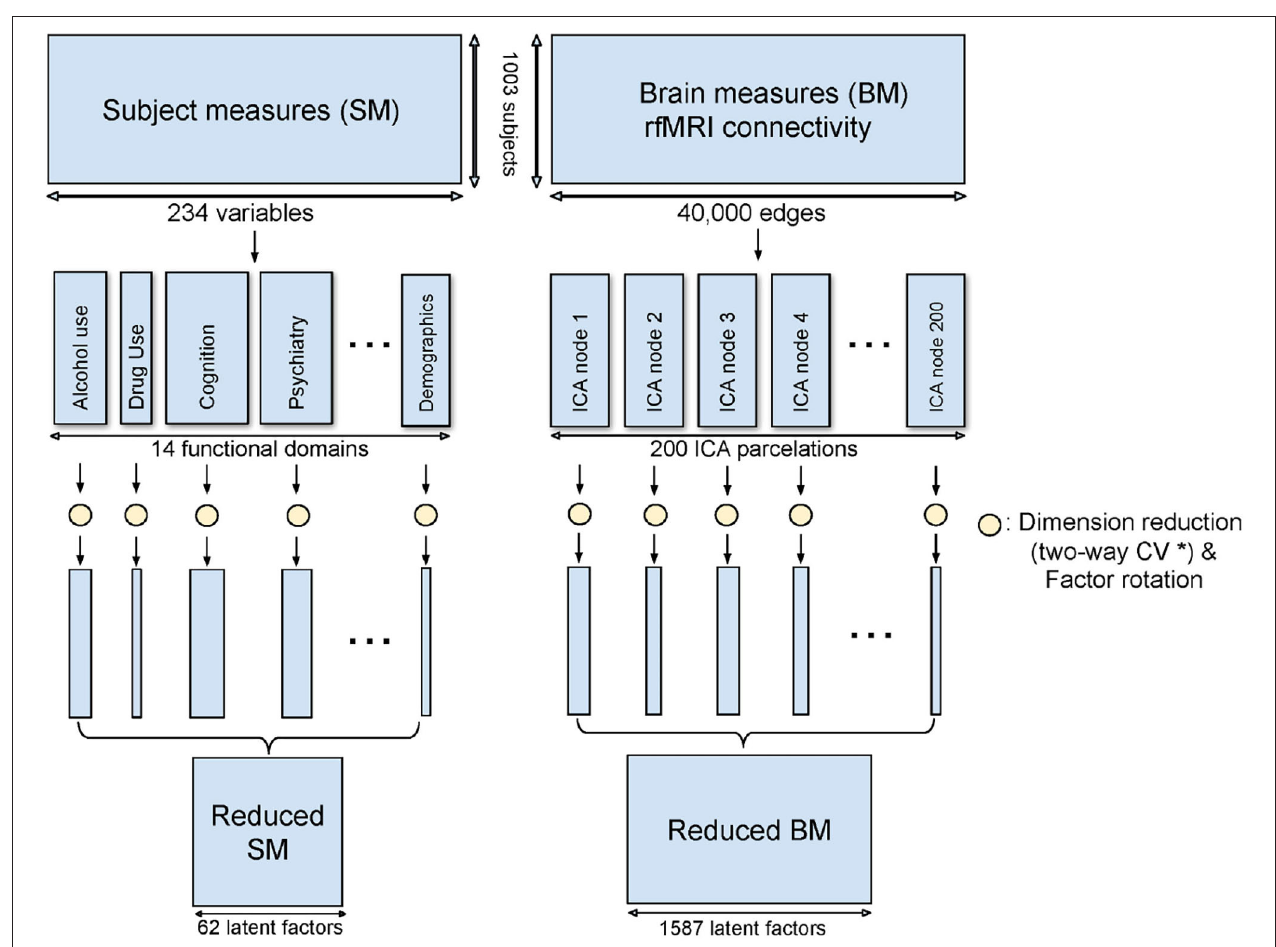
FIGURE 1 | Method overview of DDR. SM and BM are first grouped into sub-domains. PCA is applied to each sub-domain while a two-way CV method ( ∗ refer to Figure 2 ) is used to estimate the dimension. The rotated principal components from all sub-domains are concatenated to form the reduced SM and